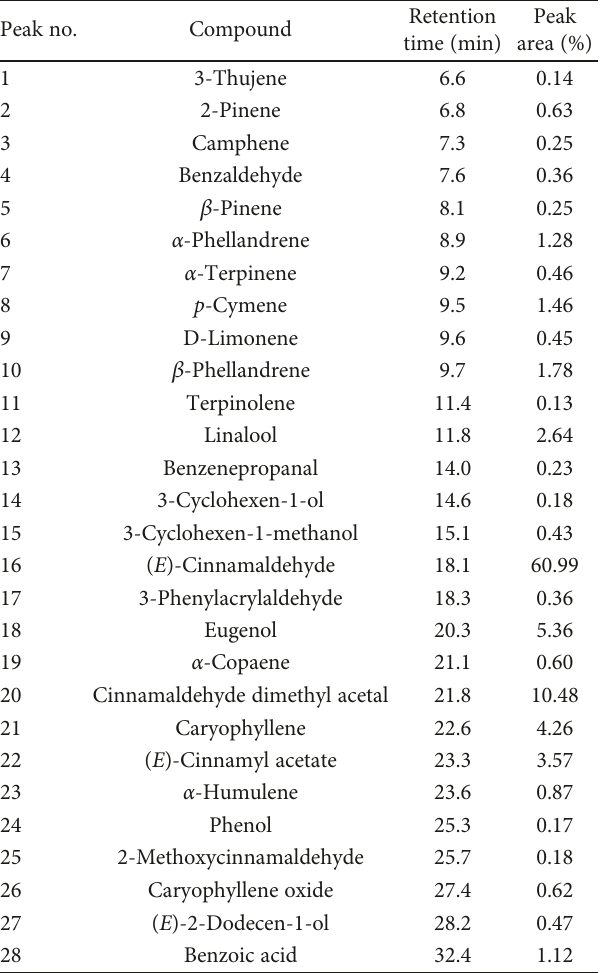
Table 1: Composition of the cinnamon essential oil. Compounds were tentatively identi fi ed by their mass spectra. Peak